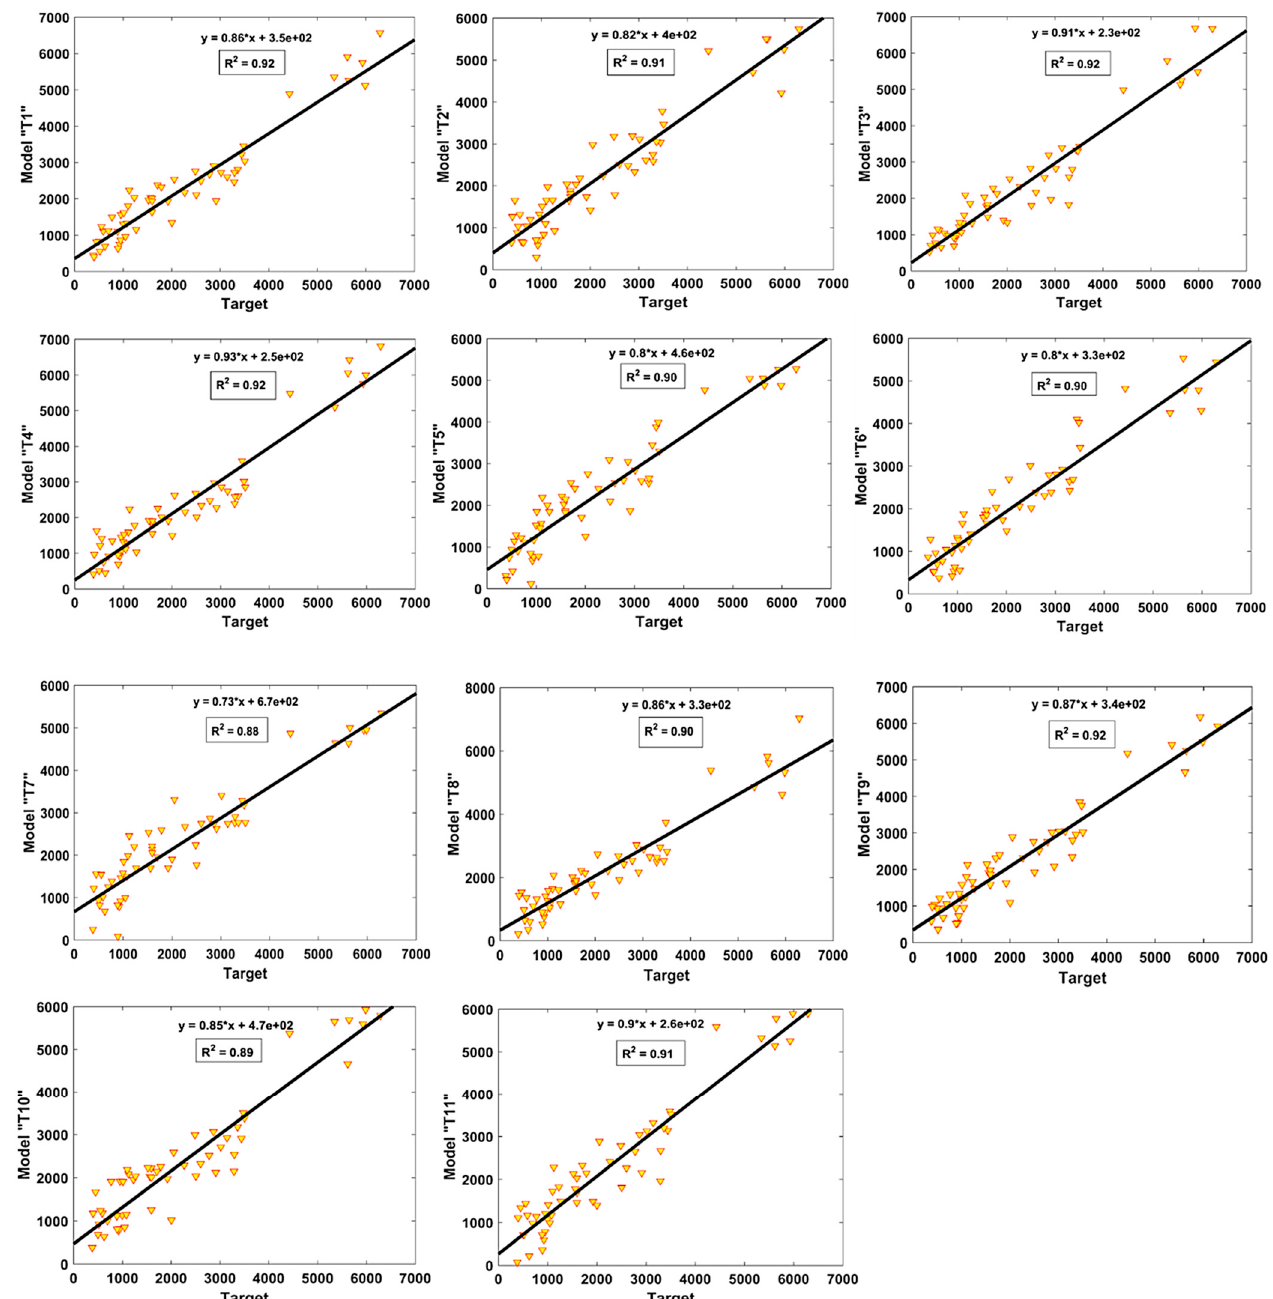
Figure 6. Comparison of regression slopes for the developed models in TR phase.